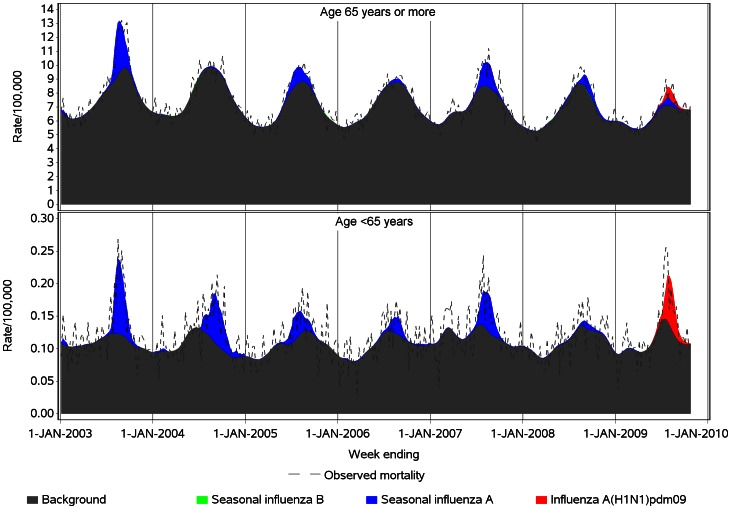
Spline model estimates of weekly influenza and non-influenza-attributable respiratory mortality in persons aged <65 and ≥65, by virus type, Australia, 2003 to 2009.Notes: 1. The influenza A laboratory detection time series was included in the regression models as a separate variable for each year, to allow for variation in laboratory reporting and testing methods, virulence of influenza strains and susceptibility of the population (see Table S1 in File S1). 2. For 2009, the seasonal influenza A laboratory detection time series was unable to be included in the regression model for <65 year-olds (see Table S1 in File S1).